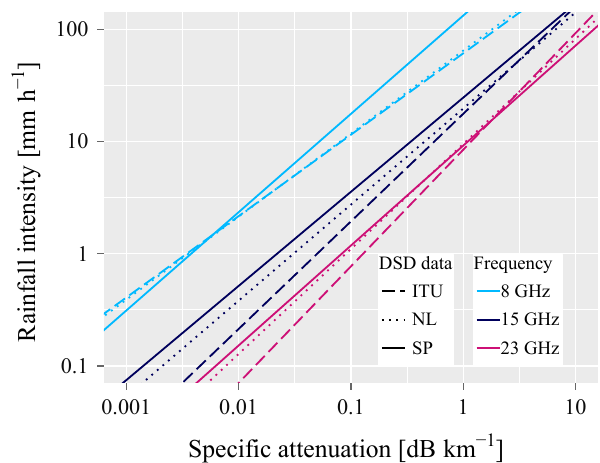
Figure 3. Rainfall intensity against specific attenuation for the a and b parameters of 3 DSD models, i.e. local (“SP” – continu- ous line), suggested by ITU-R recommendation P.838-3 (“ITU” – dashed line), and RAINLINK’s default (“NL” – dotted line). The R − k relations are presented for 3 frequencies: 8 (cyan), 15 (blue), and 23GHz